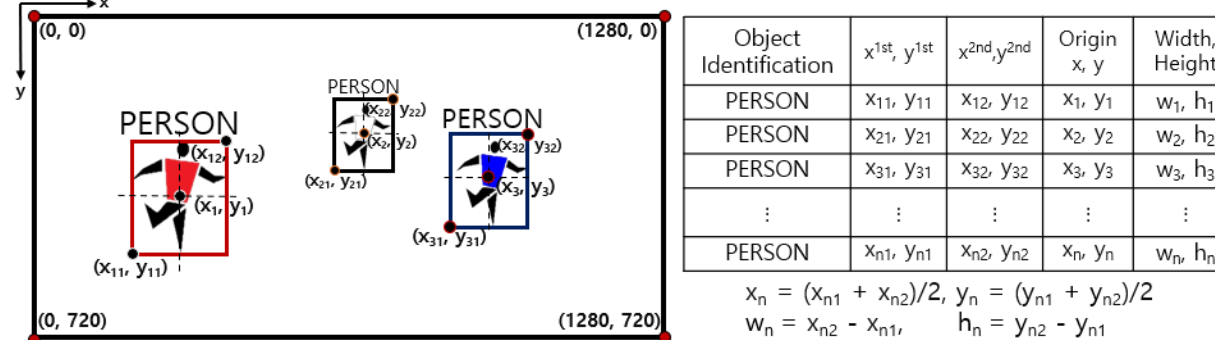
Figure 1. Information of object coordinates within an image.